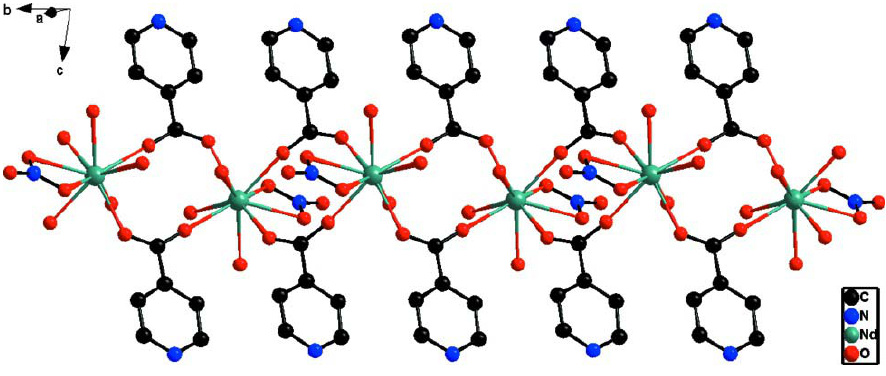
View of the polymeric chain. H atoms, perchlorate anions and uncoordinated water molecules are not shown for